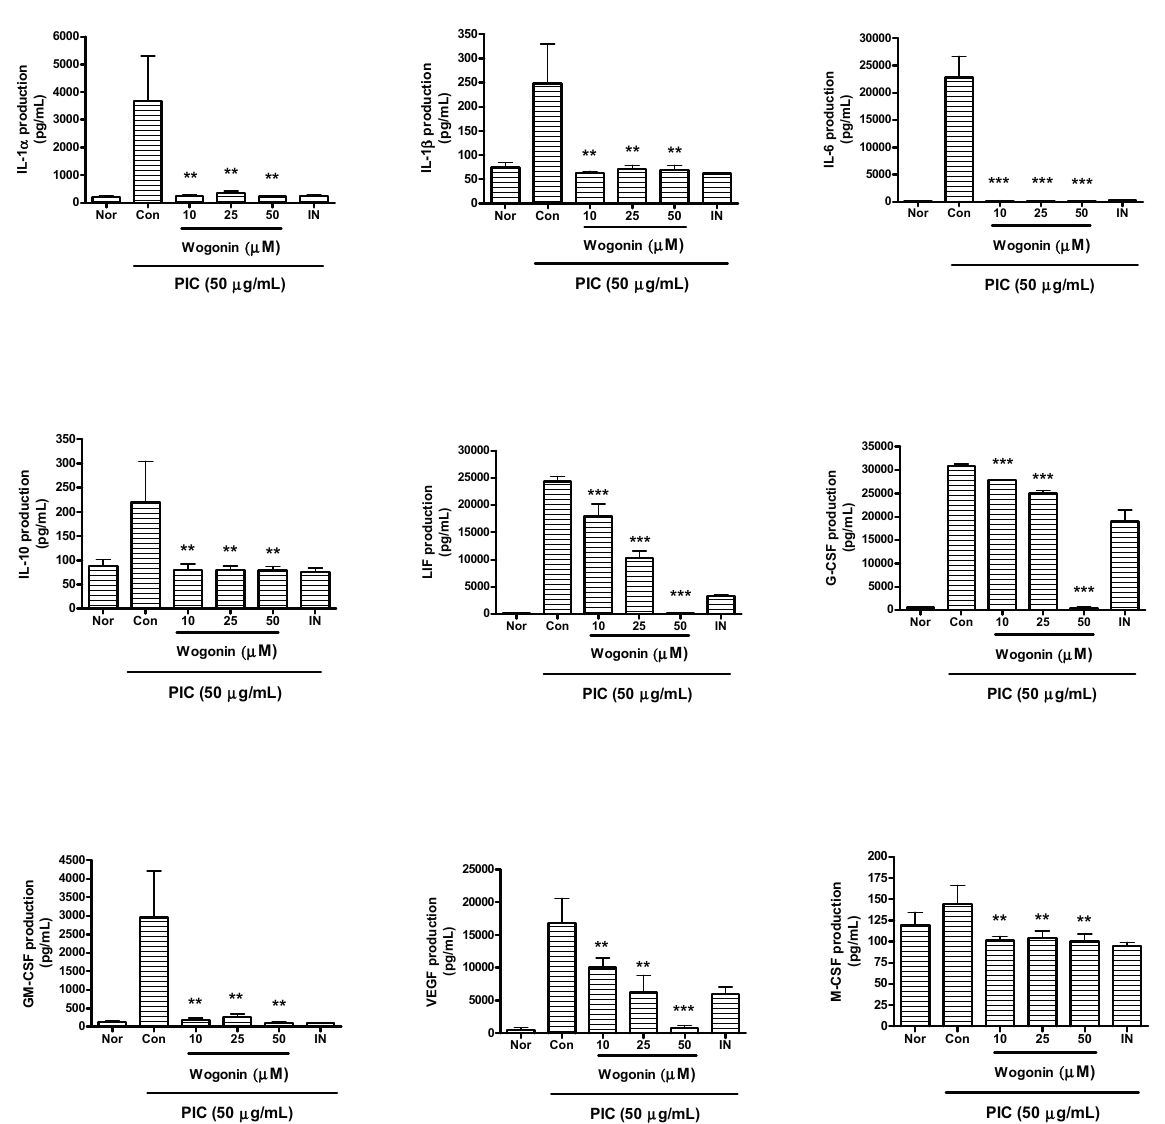
Figure 3. Effects of wogonin on production of cytokines such as IL-1 α , IL-1 β , IL-6, IL-10, LIF, G-CSF, GM-CSF, VEGF, and M-CSF in dsRNA-induced RAW 264.7 mouse macrophages. Flourescene intensity of each cytokine in the culture medium was measured by a Multiplex bead-based cytokine assay after 24 h incubation. Normal group (Nor) was treated with media only. Control group (Con) was treated with PIC (the synthetic analog of dsRNA, 50 µg/mL of polyinosinic-polycytidylic acid) alone. IN denotes indomethacin (0.5 µM). Values are the mean ± SD of three independent experiments. ** P < 0.01 vs. Con; *** P <